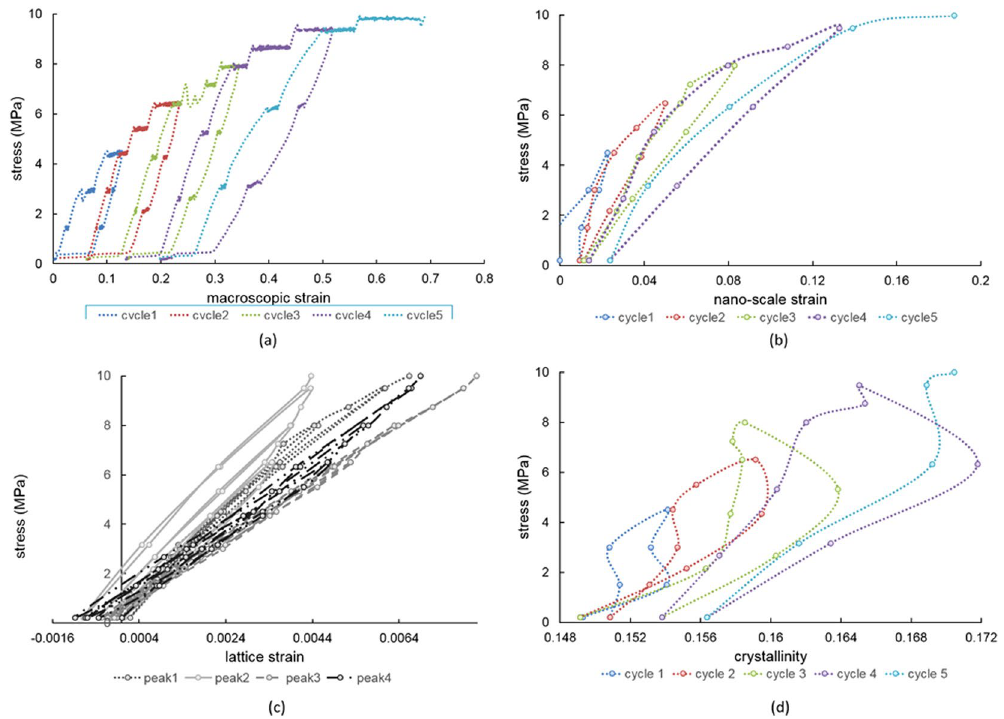
Figure 2. Multi-scale strains visualization. (a) Macroscopic strain evolution registered by Deben loading rig; (b) Nano-scale strain evolution interpreted from SAXS patterns along loading direction; (c) Atomic scale strain evolution derived from four diffraction peaks of WAXS patterns; (d) Crystallinity evolution obtained from WAXS